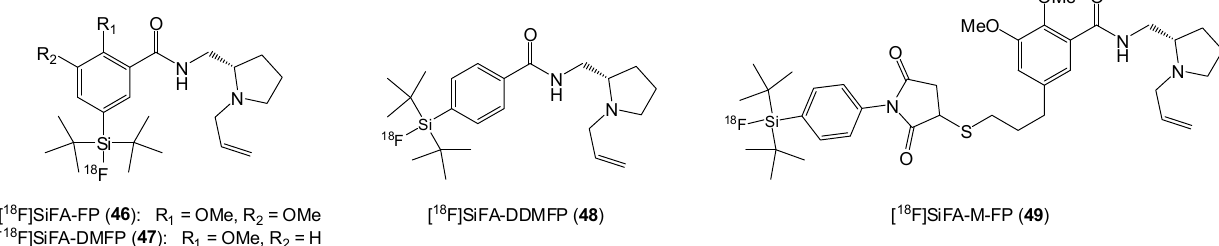
-receptor ligands 46–49 2